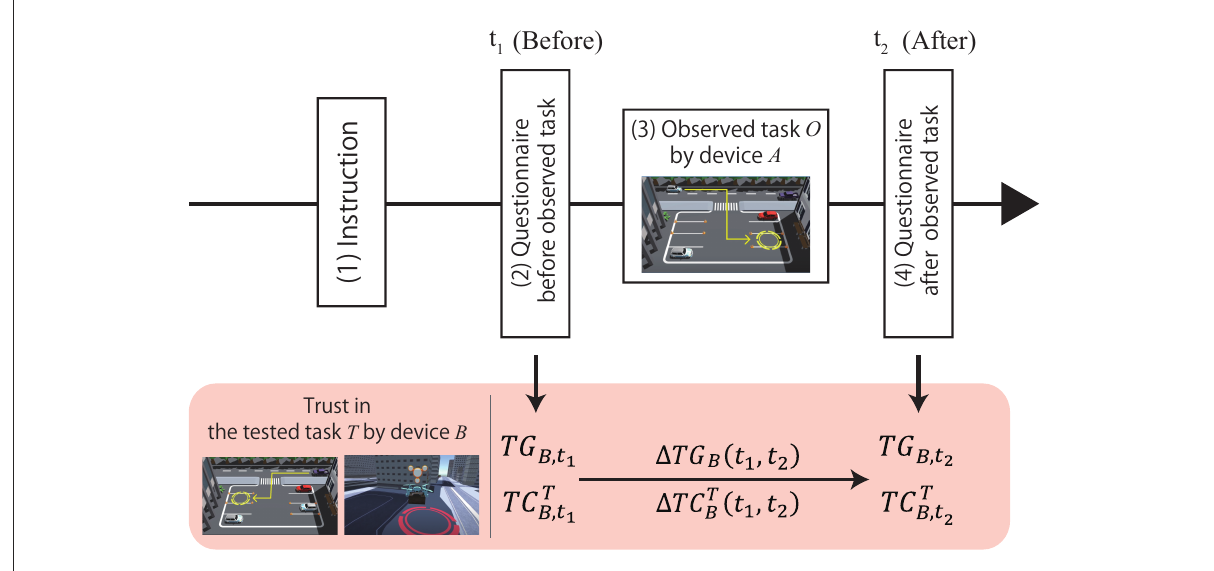
FIGURE1 Experimental procedure proceeded from left to right, and t n at top indicates when participants answered questionnaire. In lower part, correspondence between time and trust value is